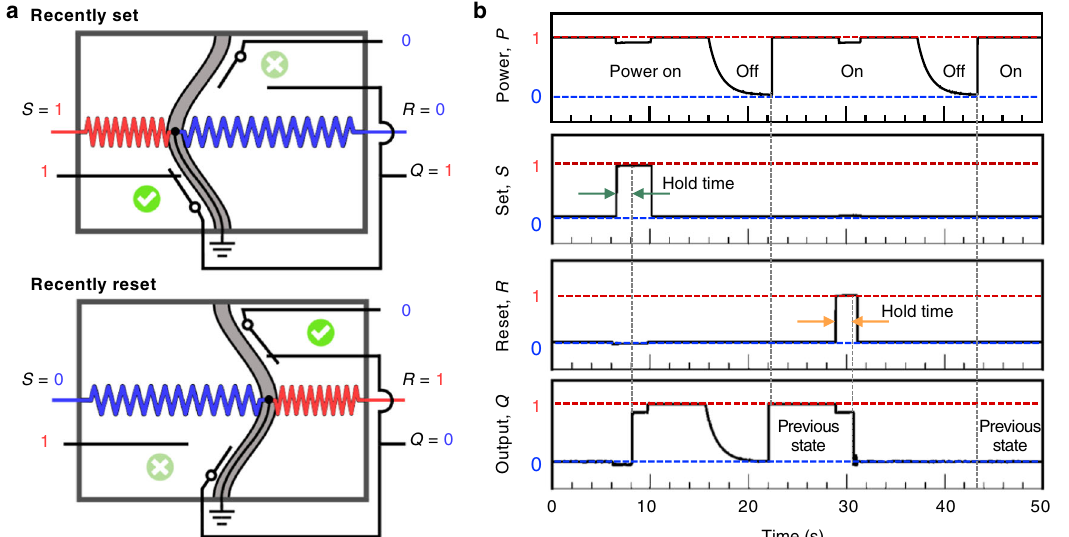
Fig. 4 | Origami memory bit. a An OMS is recon fi gured as a set-reset latch for information storage. The S and R represent SET and RESET. If the latch is set, it outputs high voltage ‘ 1 ’ ; if reset, it yields low voltage, ‘ 0 ’ . b Demonstration